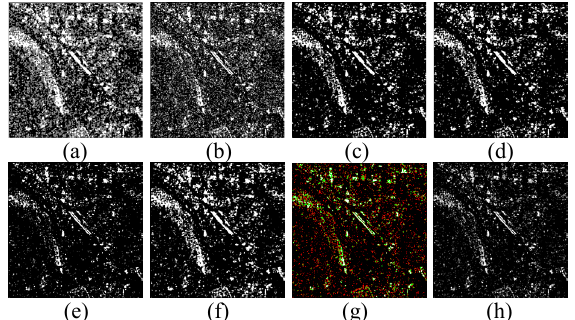
Figure 9. Sample selection results of (a) NR-FCM3; (b) LMR- FCM3; (c) LR-FCM3; (d) LR-HFCM; (e) LMR-HFCM; (f) NR-HFCM; (g) Proposed method before merge; and (h) Proposed method after merge.